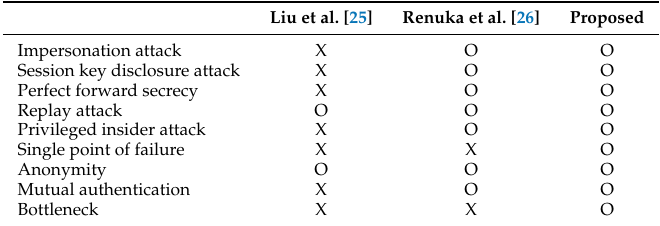
Table 5. Security properties of the proposed scheme with related